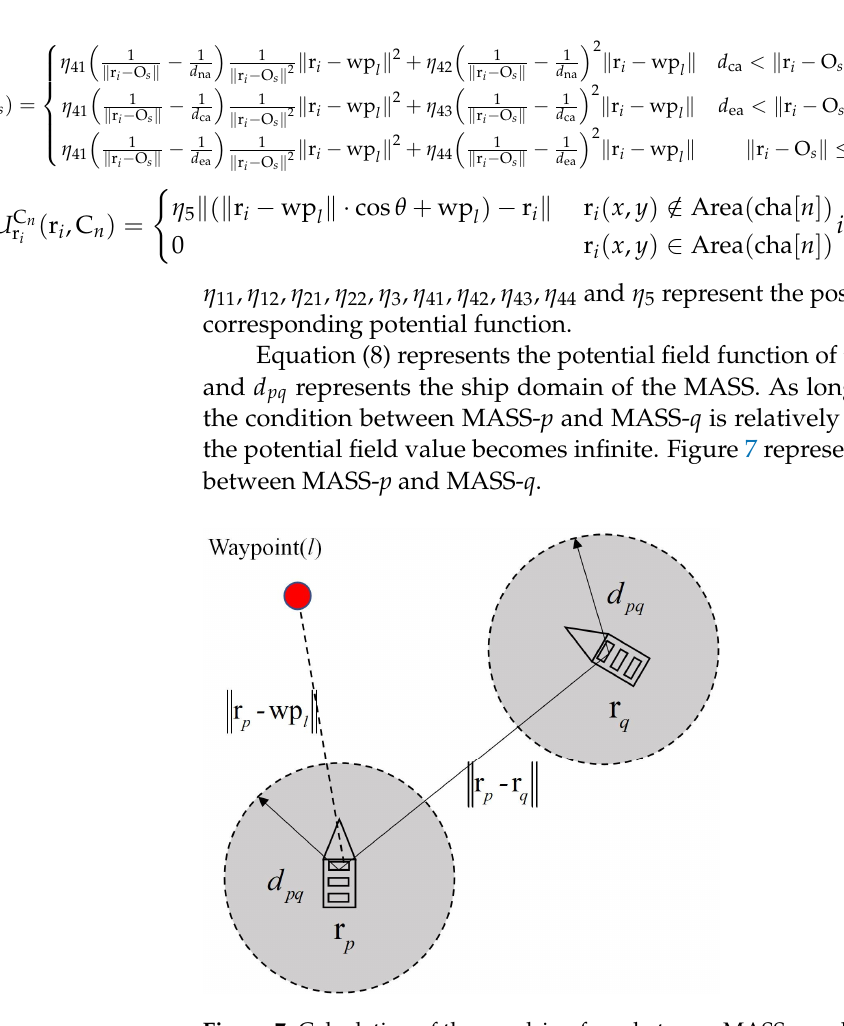
Figure 8. Process of leader ship passing through multiple waypoints.